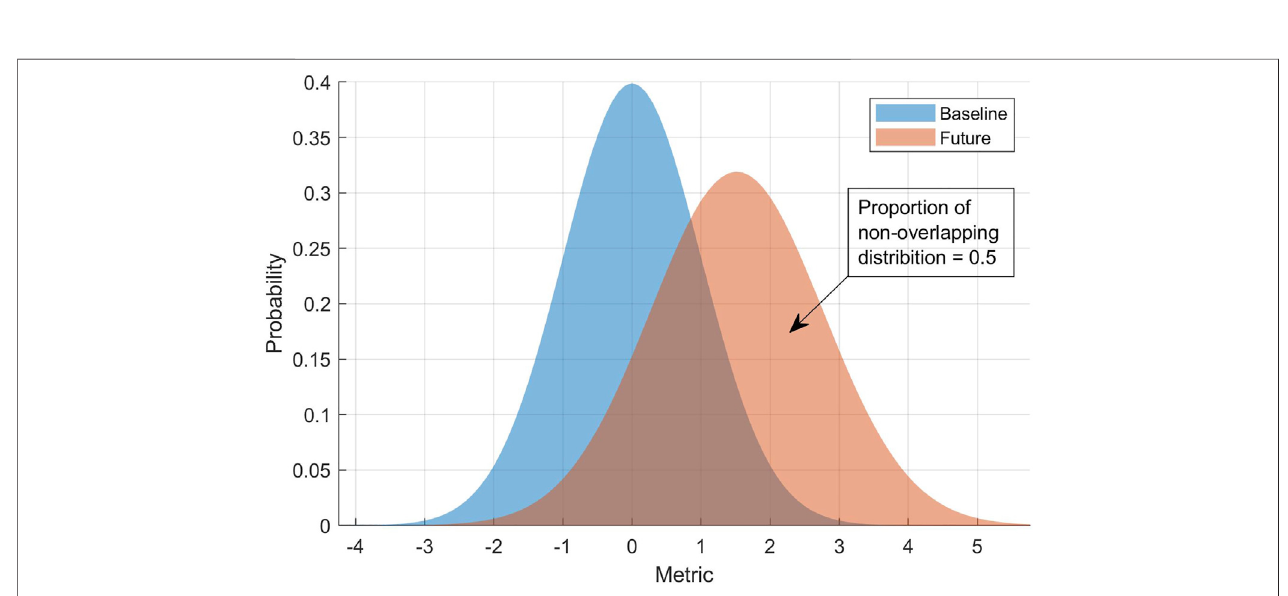
FIGURE4| Illustration ofhowthetolerabilityrangeiscalculated,afterNathanetal.(2019).Whentheproportionofthenon-overlapping futuredistributionisgreater than 0.5, the dominant in fl uence on the distribution of outcomes shifts from existing (or natural) variability to the imposed (climate) change.